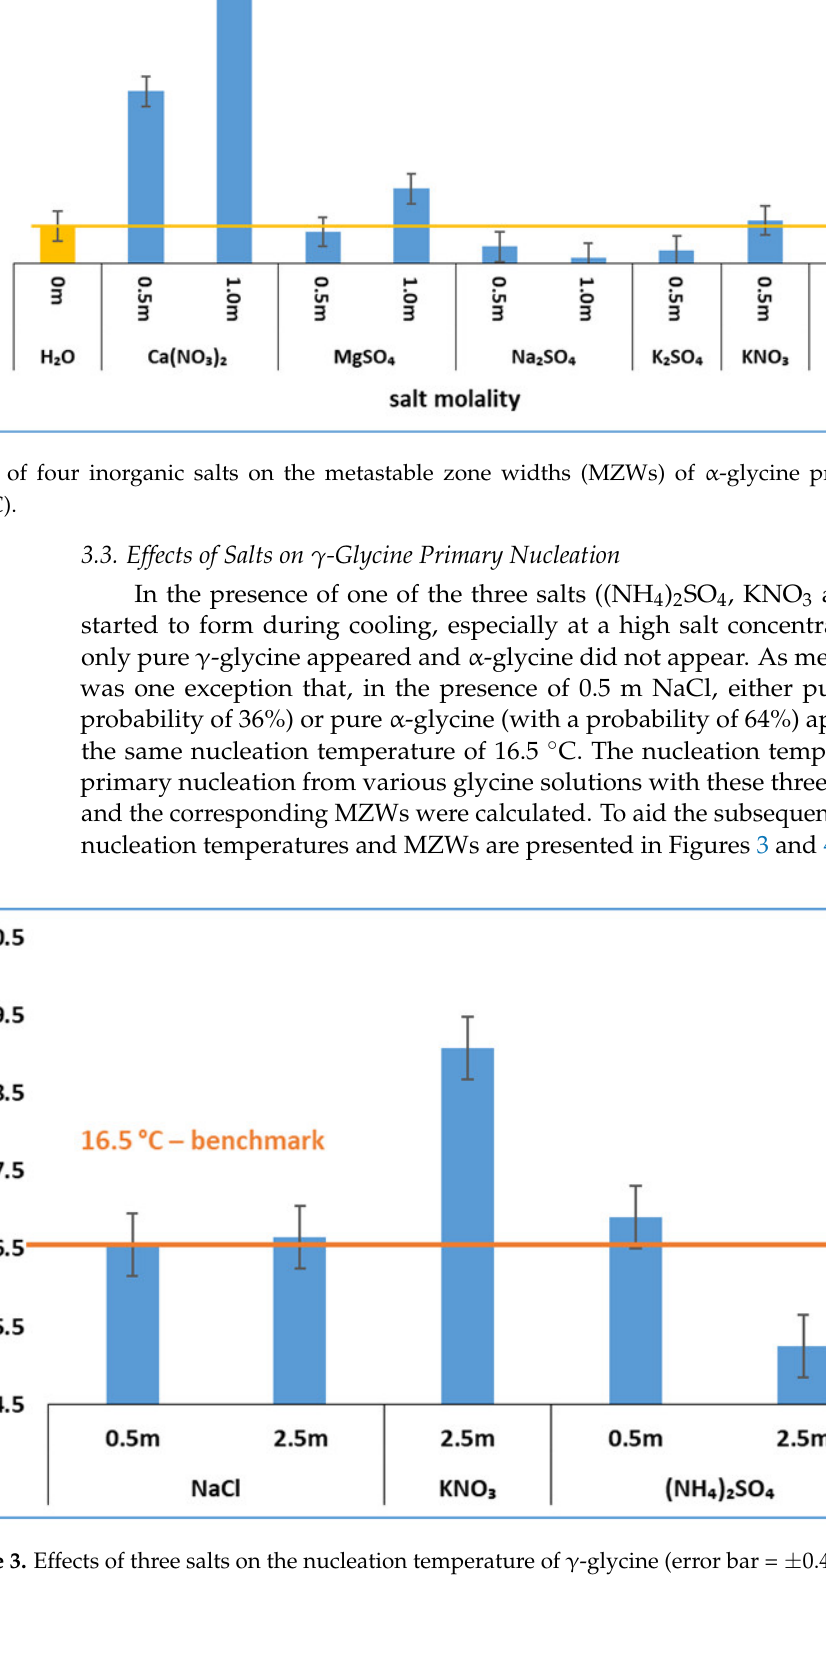
Figure 4. Effect of three salts on the MZWs of γ-glycine nucleation (error bar = ±0.4 °C). Over the period from nucleation onset to the point just before the harvest of the glycine crystals, the glycine concentration in the liquid phase was determined and it was found to be higher than α-glycine solubility at the nucleation temperature. Note that the α-glycine solubility at a nucleation temperature was predicted by our pre-established linear solubility–temperature relationships (Section 3.1). In this case, as analyzed earlier, if the metastable α-glycine was not detected and the stable γ-glycine was induced by the salts, then the salt-induced γ-glycine was supposed to originate from γ-glycine primary (rather than secondary) nucleation. The formation of salt-induced γ-glycine is the outcome of relative competition be- tween α-glycine and γ-glycine. In other words, neither salt-associated promotion of γ-glycine nor salt-associated inhibition of α-glycine can be concluded from the salt-assisted α-to-γ polymorph shift. In addition, since γ-glycine does not appear from a pure glycine solution, the quantitative MZW of γ-form from a pure solution is intrinsi-